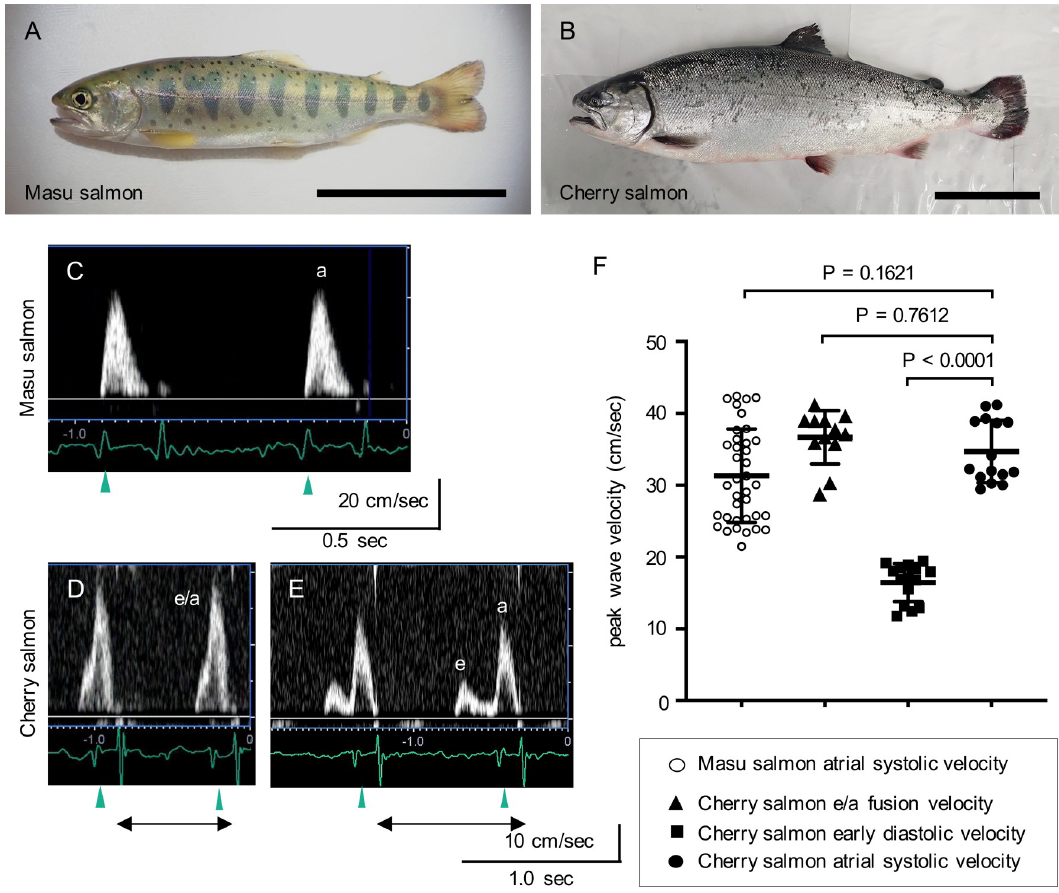
Fig 1. Recordings of the waveforms of the atrioventricular inflows in masu and cherry salmon using pulsed-wave echocardiography. (A, B) Representative Oncorhynchus masou masou pictures: (A) masu salmon at 29 months post fertilization, (B) cherry salmon reared in seawater for five months after being reared in freshwater for 24 months. Scale bars = 10 cm. (C, D, E) Representative velocity waveforms of atrioventricular inflows in the masu (C) and cherry salmon of monophasic (D) and biphasic patterns (E). Blood passing the atrioventricular valve was observed using pulsed-wave Doppler echocardiography simultaneously with electrocardiography. Green arrowheads indicate P waves. Black left–right double arrows indicate R-R intervals. a: atrial systolic velocity, e/a: fusion velocity of atrial systolic and early diastolic inflows, e: early diastolic velocity. (F) Peak wave velocity. � : masu salmon atrial systolic velocity (31.3 ± 6.4 cm/s, N = 37 peaks from five fish), ▲ : cherry salmon early diastolic waves and atrial systolic waves (e/a) fusion velocity (36.7 ± 3.6 cm/s, N = 12 peaks from two fish), ■ : cherry salmon early diastolic velocity (16.5 ± 2.6 cm/s, N = 15 peaks from two fish), ● : cherry salmon atrial systolic velocity (34.7 ± 4.2 cm/s, N = 15 peaks from two fish). Lines and error bars indicate the mean ± standard deviation. Minimal data sets for atrioventricular velocities are found in S1 File.